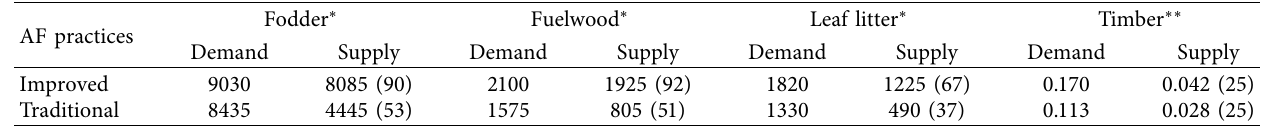
Table 1: Demand of the local household and contribution from agroforestry practice.